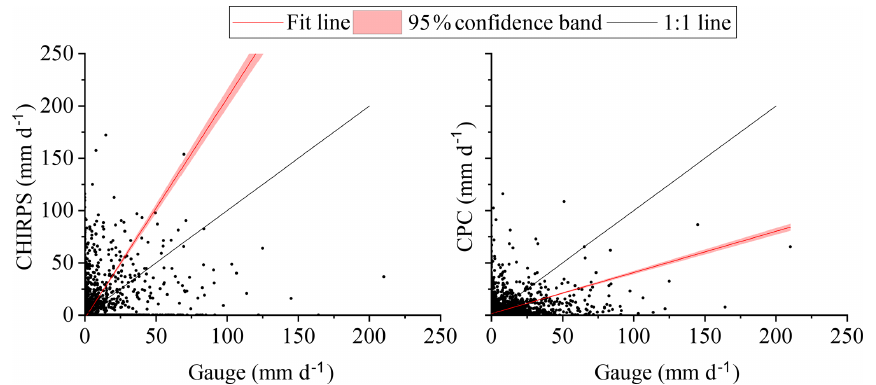
Figure 5. Scatterplot of the OPP records compared with Gauge records at a daily scale: (a) comparison of CHIRPS and Gauge and (b) com- parisons of CPC and Gauge.